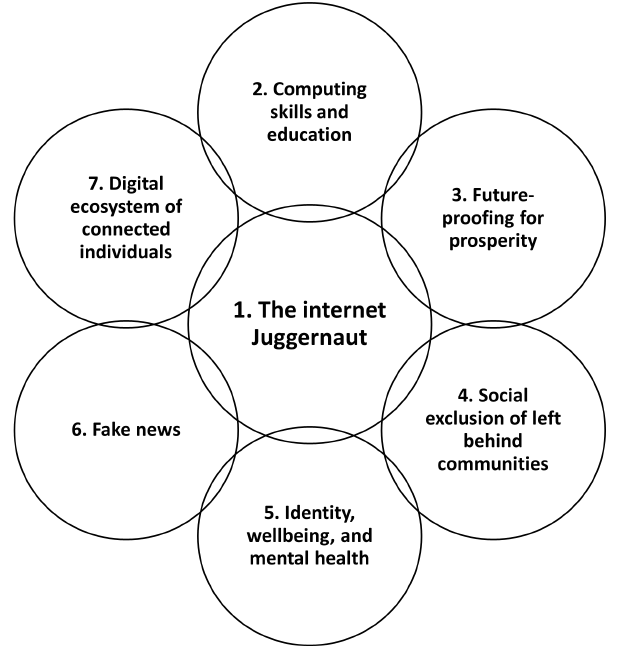
Figure 1: The internet Juggernaut and associated